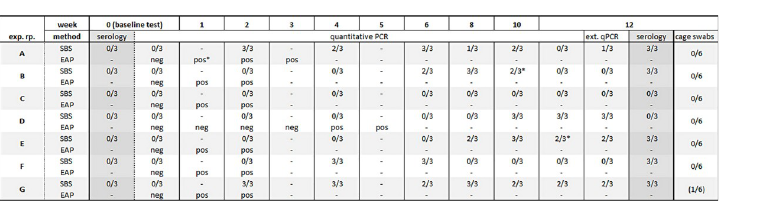
Fig 2. Comparison of qPCR and serology results for soiled-bedding sentinel (SBS) and Exhaust Air Particle (EAP) monitoring at known prevalence of MuAstV. MuAstV = Murine Astrovirus; Exp. rp. = Experimental repetition; SBS = Soiled bedding sentinels; EAP = Exhaust air particle; ext. qPCR = quantitative PCR performed at an external provider; pos = positive EAP qPCR result for MuAstV; neg = negative EAP qPCR result for MuAstV; numerals = number of positive Sentinels per number sentinels tested for qPCR or serology dash, not tested; asterisk, samples between 0–1 copy / μ L.